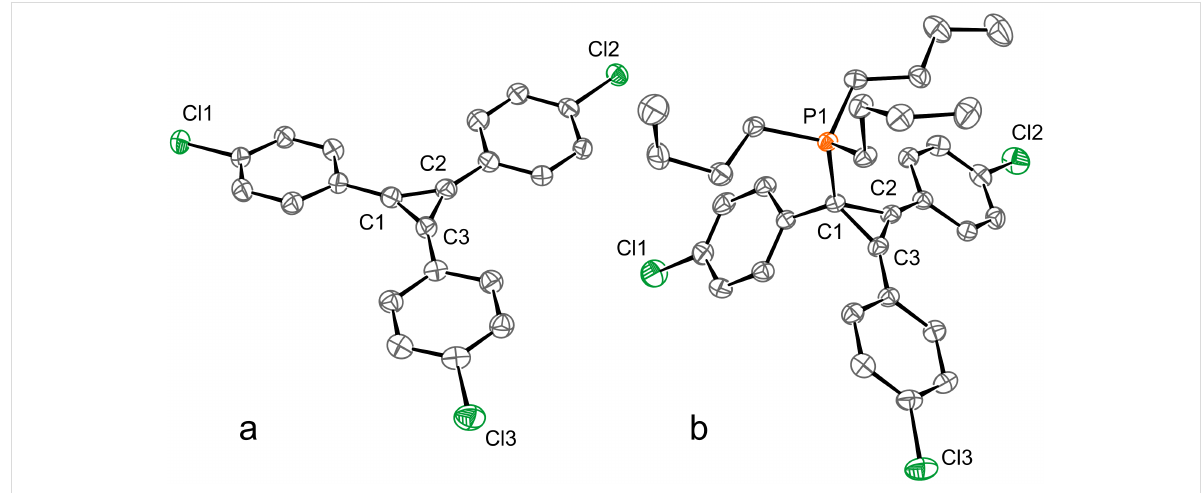
Figure 1: ORTEP representations for cations 5c (a) and 6c (b) at the 50% probability level. Bromide anion and co-crystallized solvent molecules are omitted for clarity. For 6c , only one of two symmetry-independent molecules is shown. Selected interatomic distances (Å): C1–C2 1.387(7), C1–C3 1.372(7), C2–C3 1.380(7) for 5c ; C1–C2 1.521(5), C1–C3 1.521(5), C2–C3 1.298(5), P1–C1 1.837(3) for 6c . Deposition numbers 2176393 for 5c and 2176394 for 6c contain the supplementary crystallographic data for this paper